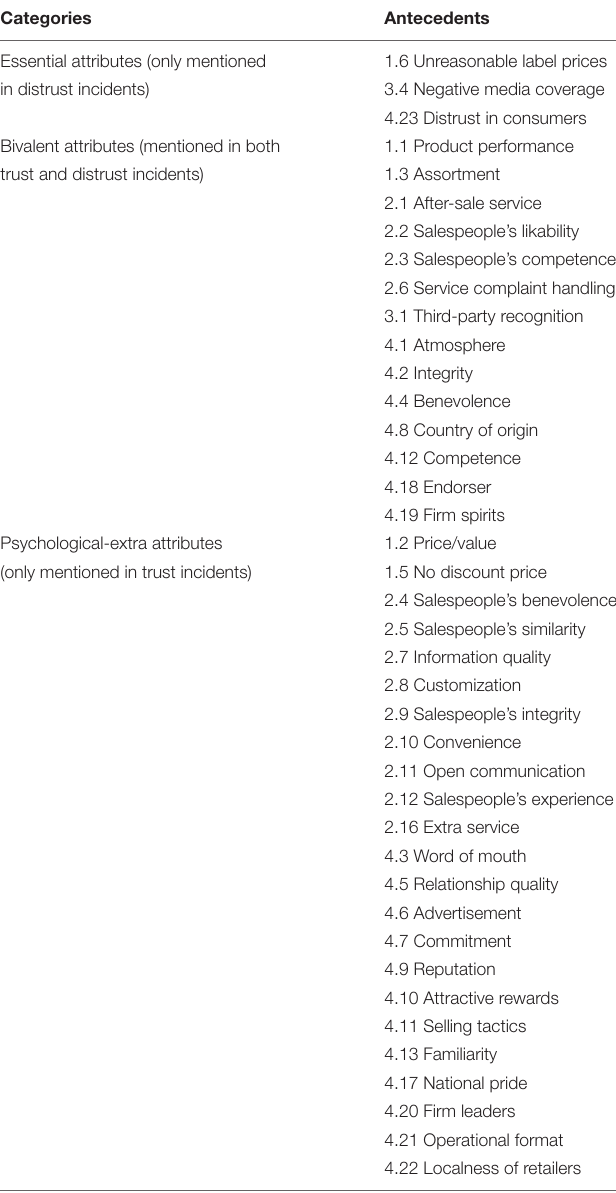
TABLE 4 | Categories of antecedents of trust and